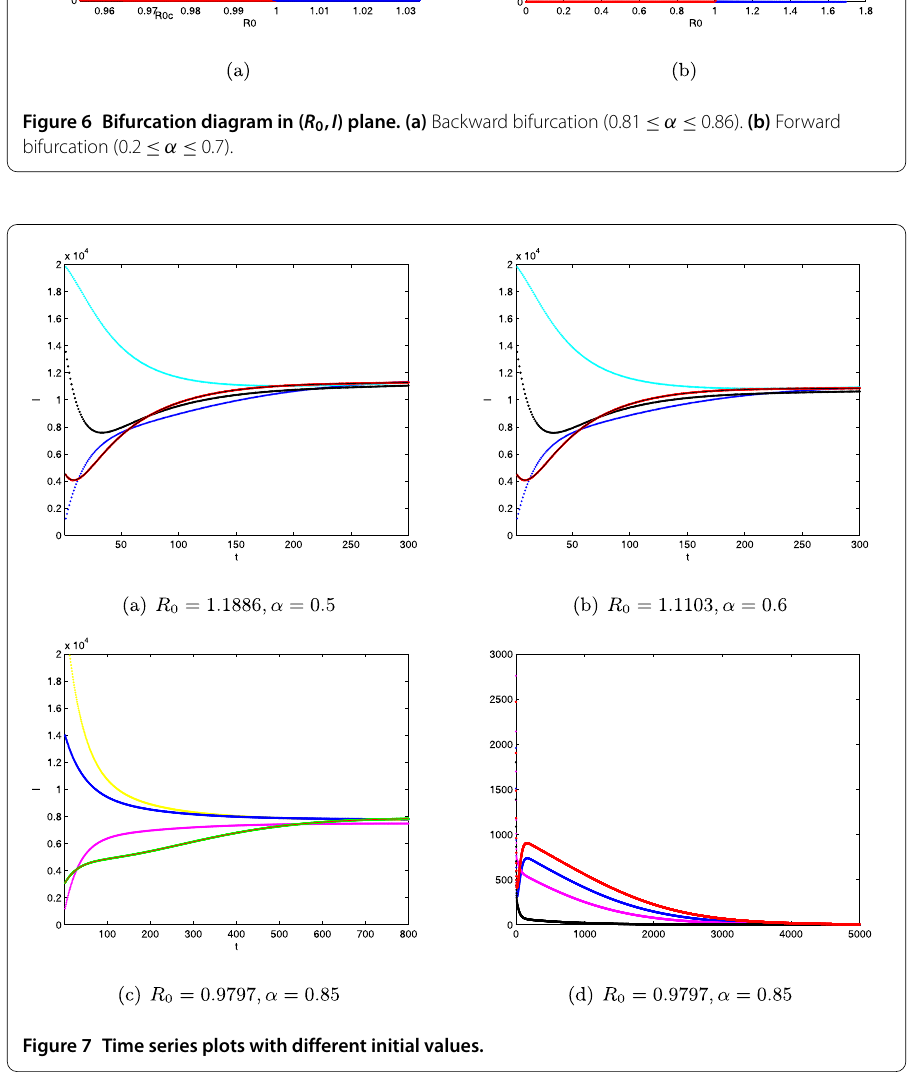
Figure 7 Time series plots with different initial